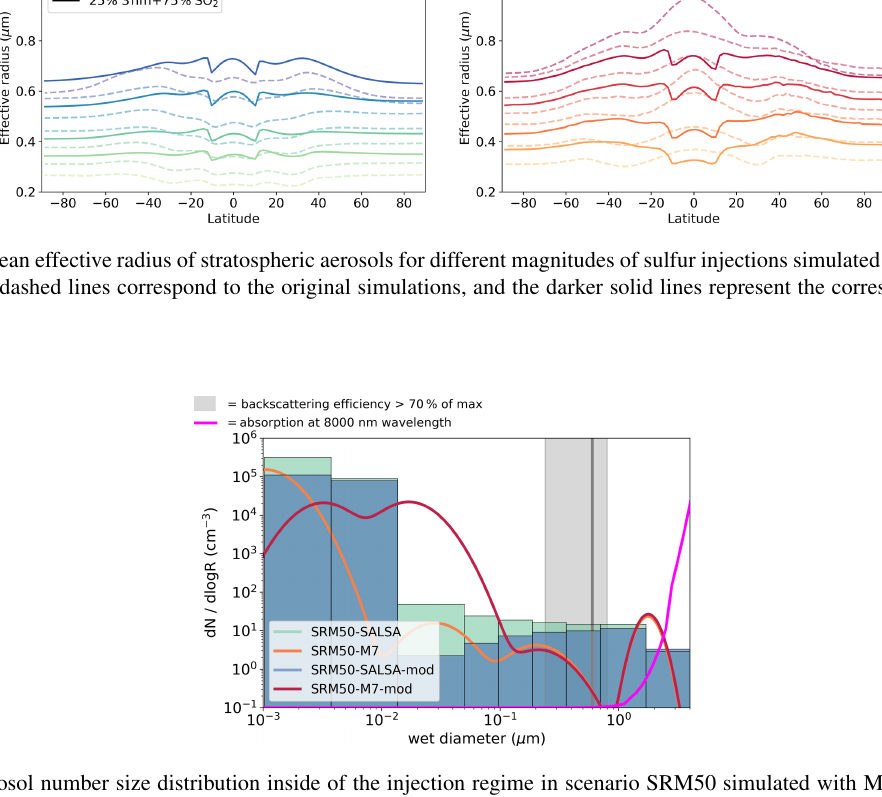
Figure A3. The aerosol number size distribution inside of the injection regime in scenario SRM50 simulated with M7 and SALSA in the original simulations and in simulations where the nucleation is replaced by injecting 25% of sulfur mass as 3nm primary particles. The grey line shows the size of the maximum backscattering, and shaded area indicates the radius where aerosol backscattering is 70% of the maximum from Dykema et al. (2016). The magenta line shows the dependence of absorption at an 8000nm wavelength on the (dry) size of the sulfate aerosols, based on the radiation module of